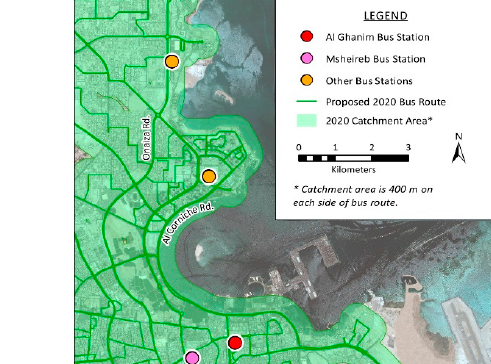
Figure 20. Transportation map showing bus routes and metro line; the “M” in the red circles stands for “metro” (Source: the Authors).